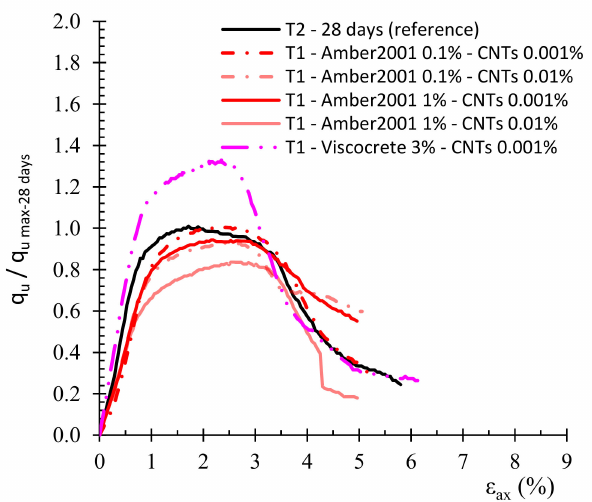
Figure 10. Stress–strain normalized curves (for samples with 28 curing days) for the stabilized soil with MWCNTs suspensions of the surfactant Amber 2001 (conc. of 0.1% and 1%) and Viscocrete (conc. of